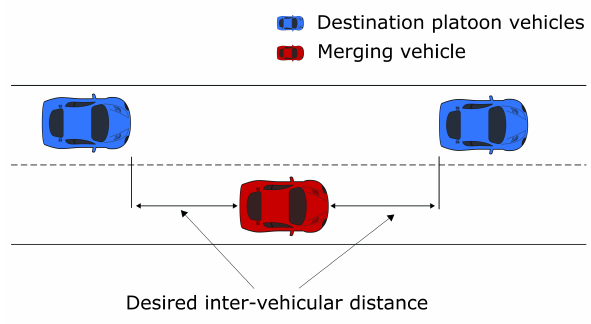
Figure 2. Illustration of gap generation.